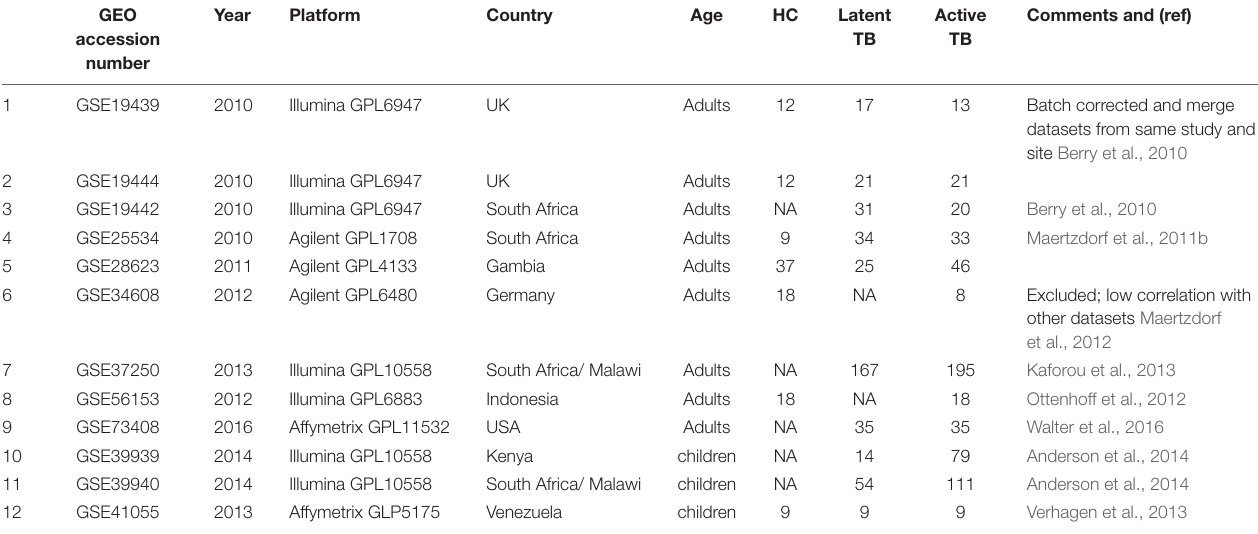
TABLE 1 | Summary of datasets included in the